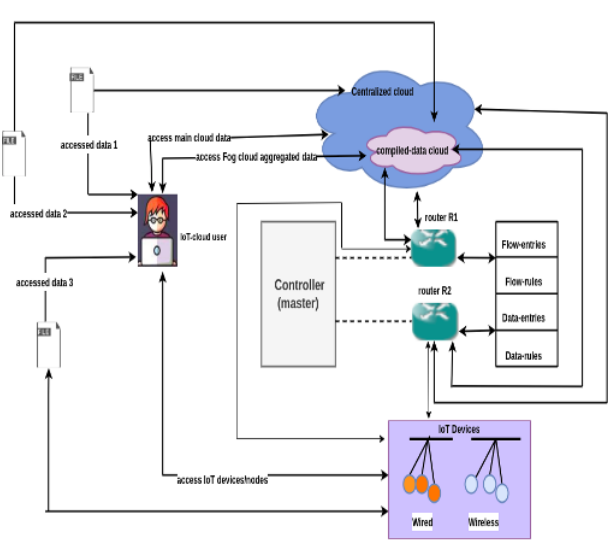
Figure 5. IoT-Cloud prevention Model from data